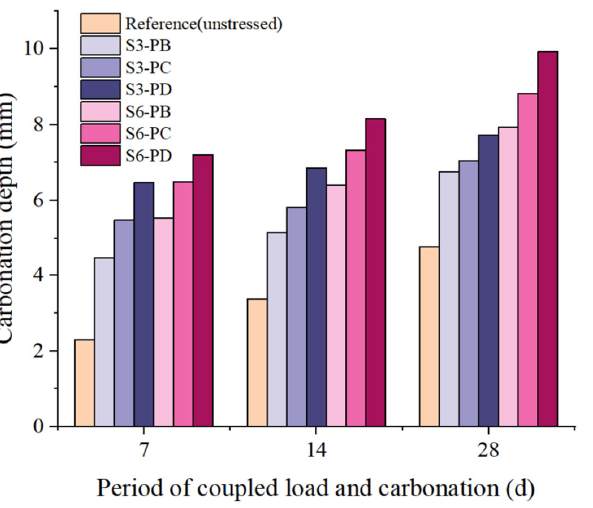
Figure 3. The measured carbonation depth of the area under different loading conditions.